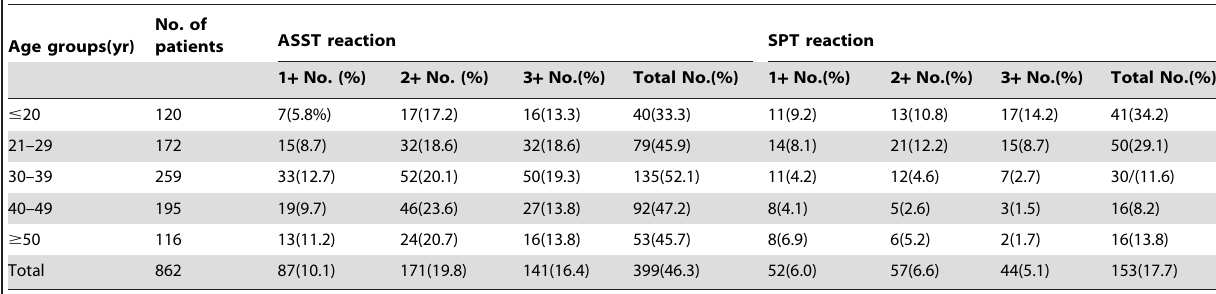
Table 1. Result of ASST and SPT to HDM in 862 patients with CSU.